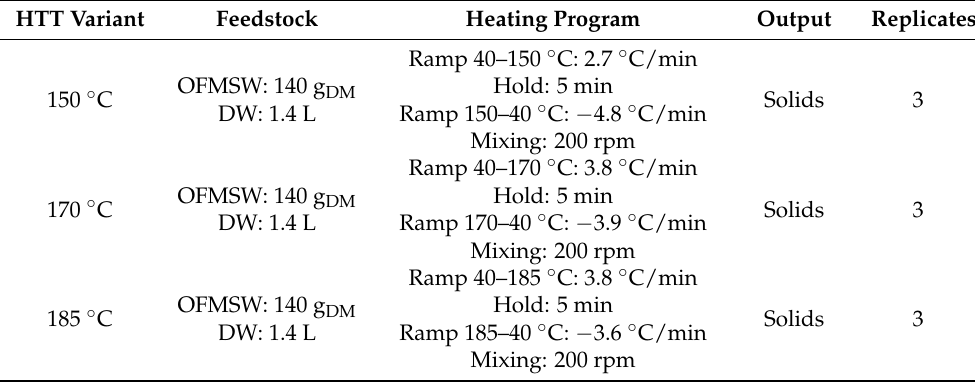
Table 1. Experimental setup for the hydrothermal treatment (HTT) of the organic fraction of munici- pal solid waste (OFMSW) based on dry matter (DM) together with distilled water (DW) including heating and cooling rates